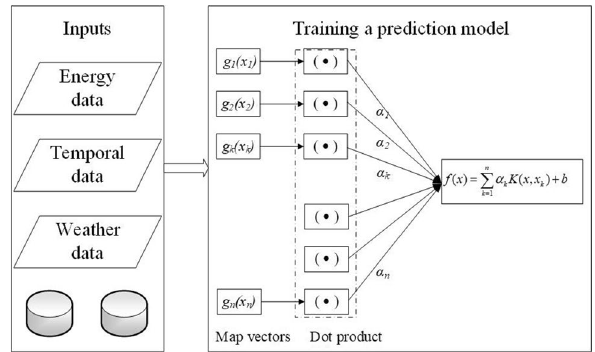
Figure 1. Training support vector regression model using energy